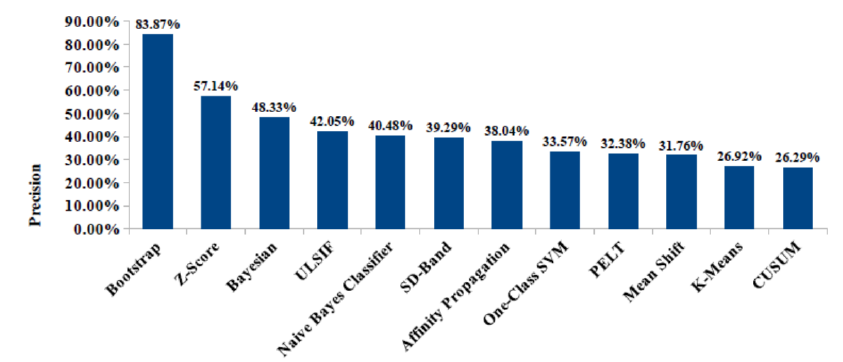
Figure 8. Precision of behavior change techniques evaluated by the